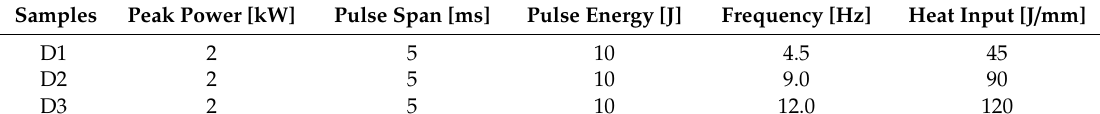
Table 2. Pulsed laser welding parameters.